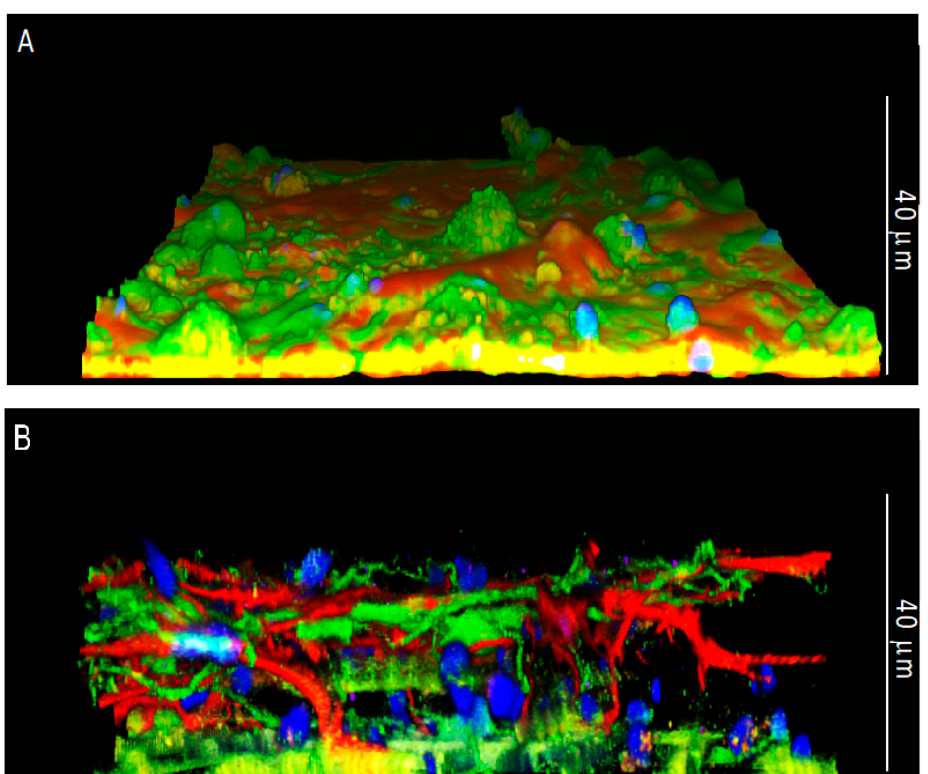
Figure 3. Confocal microscopy of DIV21 hippocampal astrocyte and neuron co-cultures in 2D and in the 3D synthetic microscaffold Nichoid. Lateral views of ( A ) 2D and ( B ) 3D co-cultures in which hippocampal astrocytes were marked with GFAP in red and neurons were marked with MAP2 in green. Nuclei were stained with Hoechst in blue. Images were taken with a 100× (oil immersion) objective.